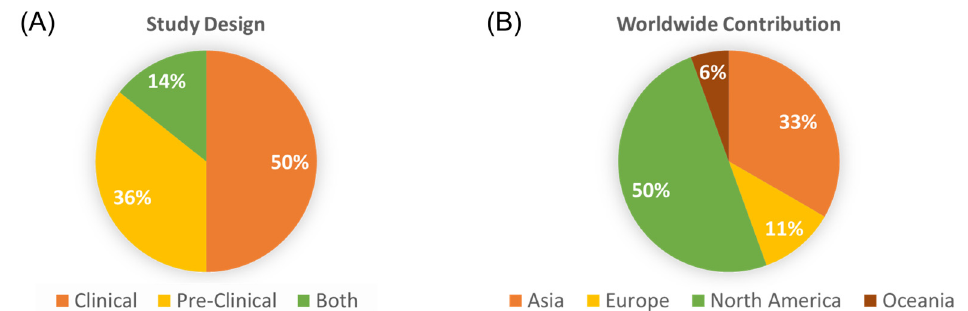
Figure 2. Study design and origin of contribution. ( A ) The percentage of studies according to the design (human subject data, pre ‐ clinical, or a combination of both); ( B ) The distribution of studies according to the continent of origin.